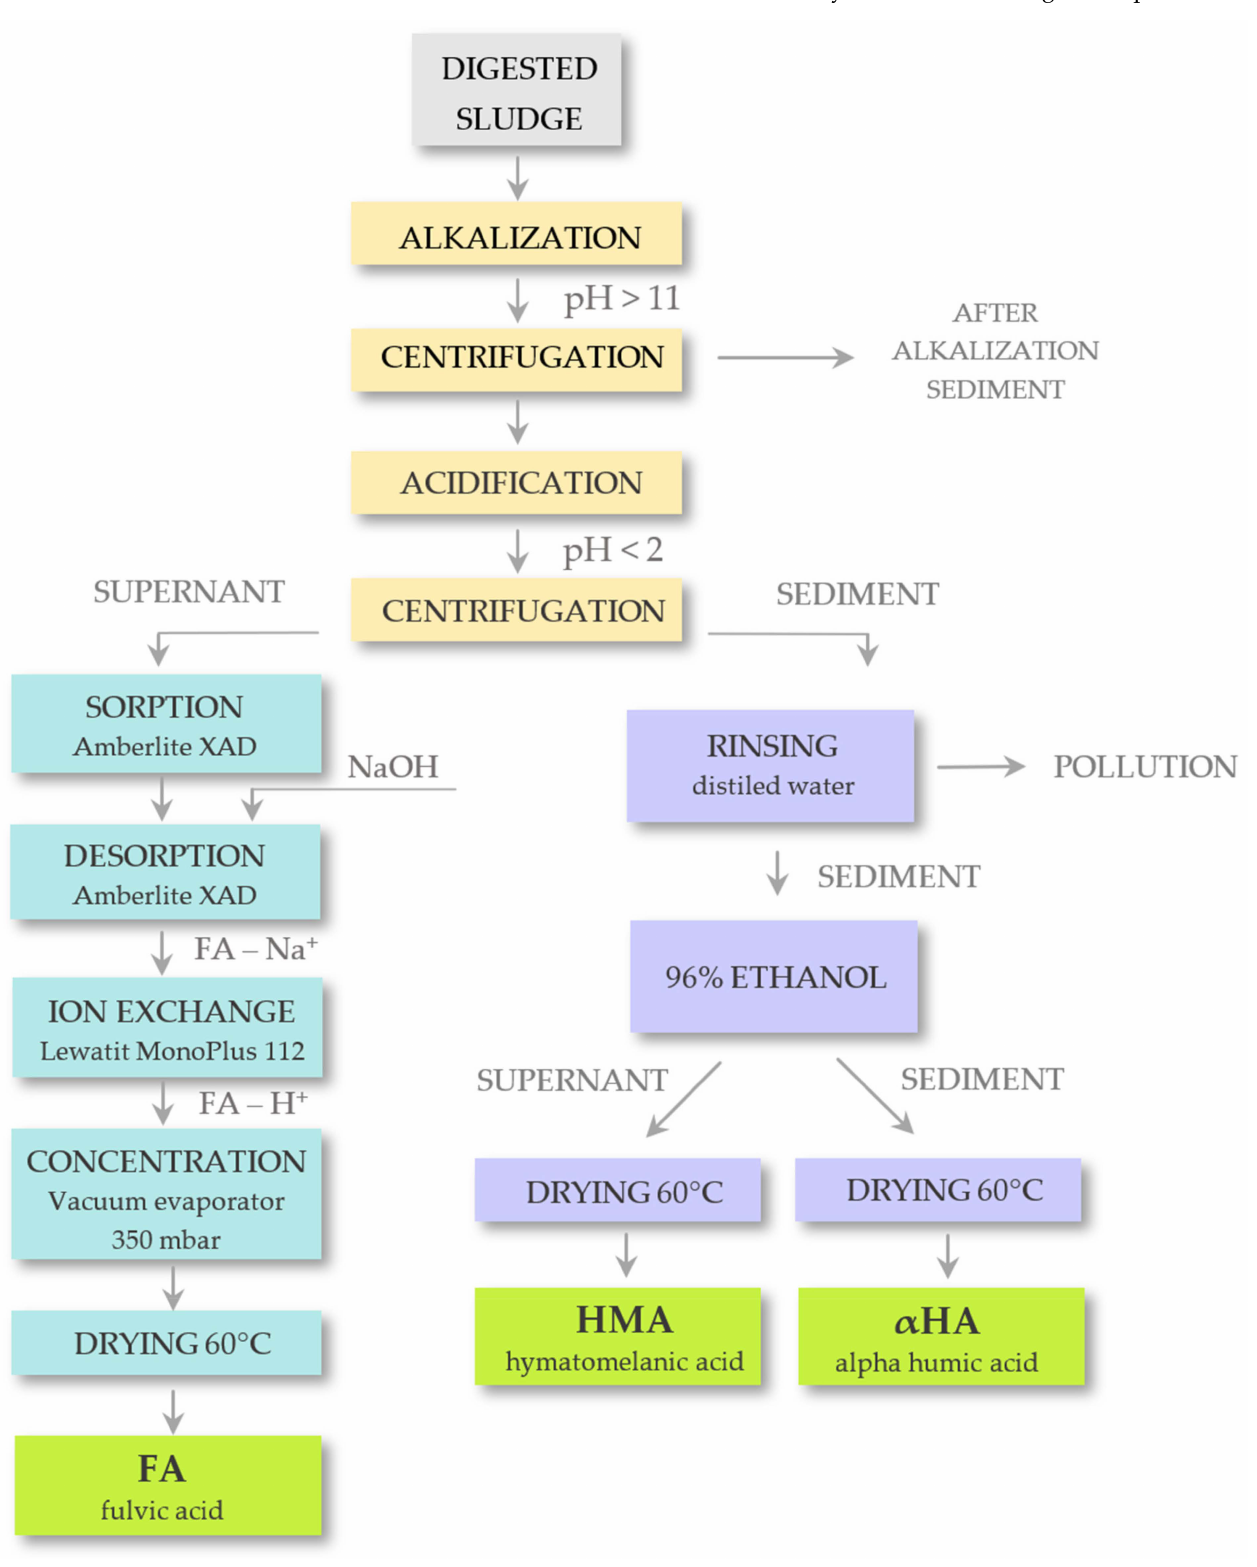
Scheme 1. Technological system for extraction of humic substances from digested